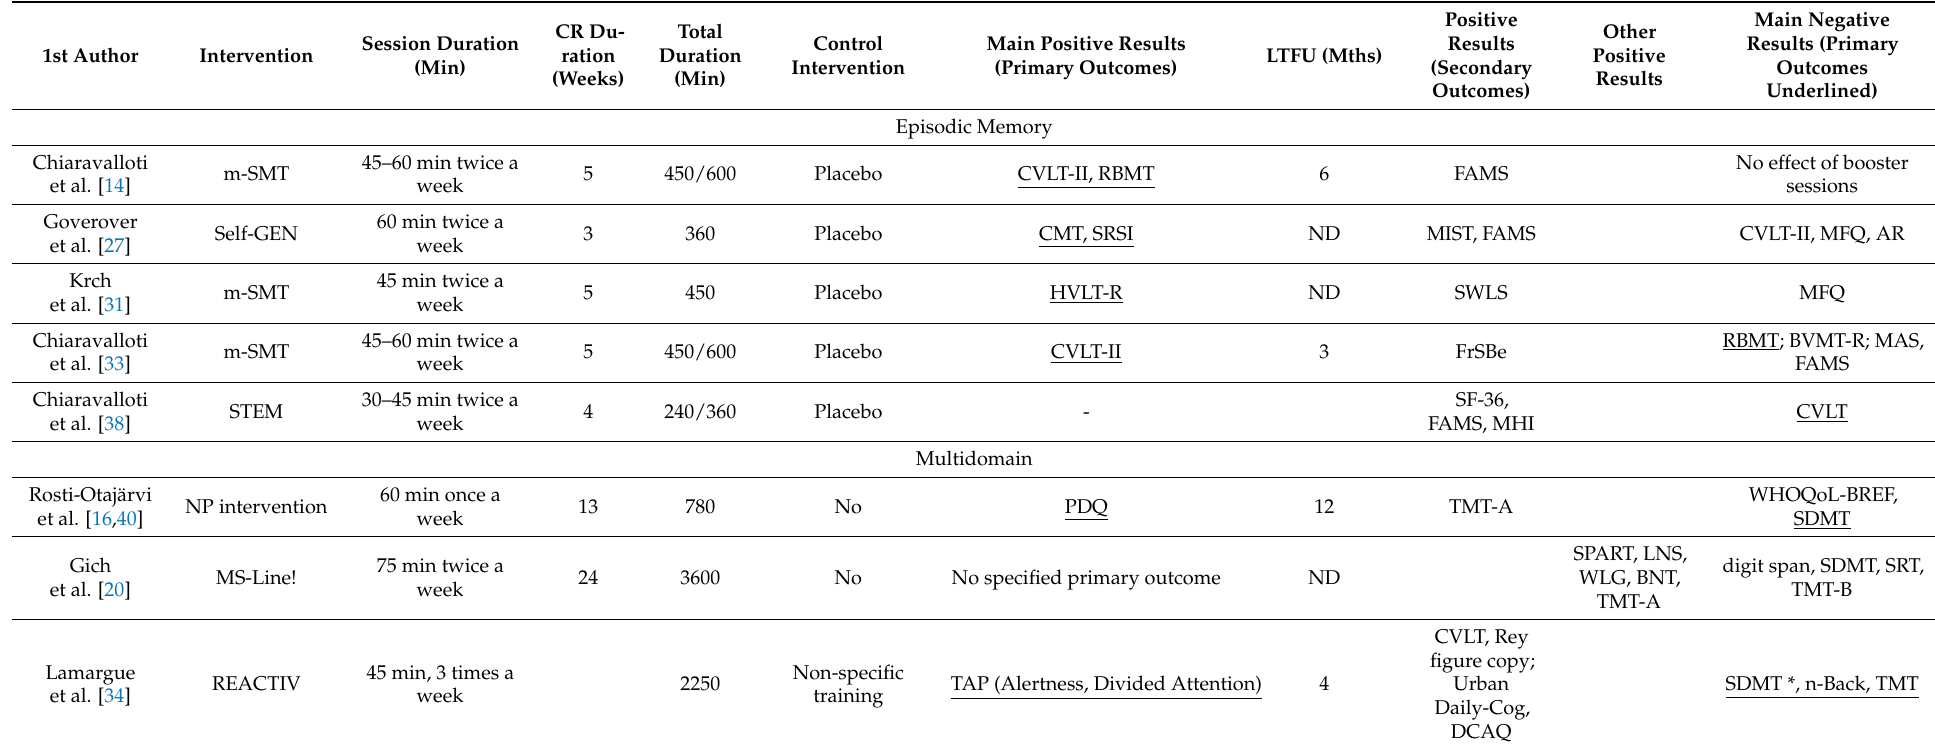
Table 3. Blinded RCT about individual-specific cognitive